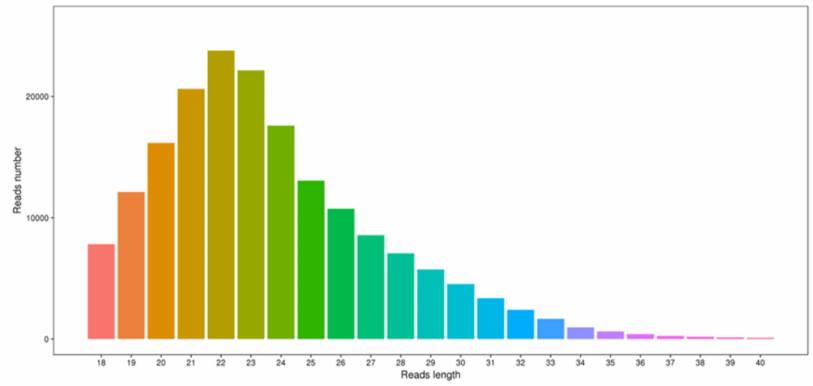
Figure 2. Small RNA length analysis